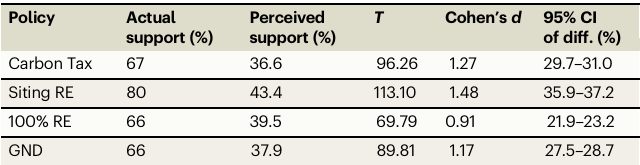
Table 1 | Differences in real vs perceived national policy support